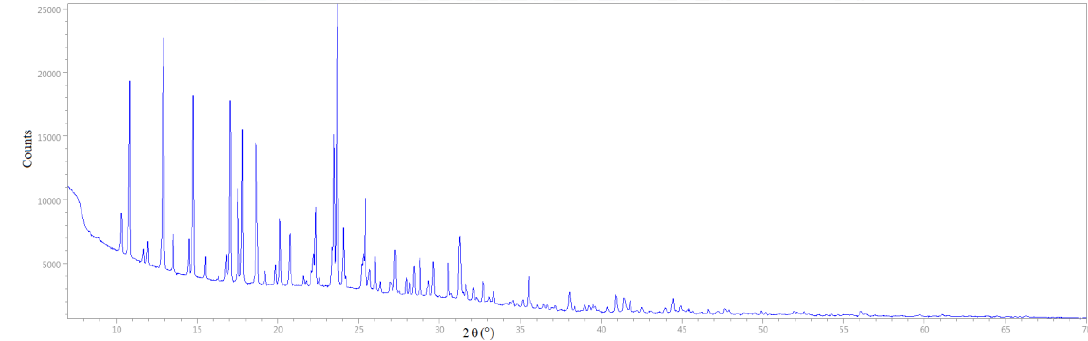
ff raction pattern of C 22 H 17 O 6 N 3